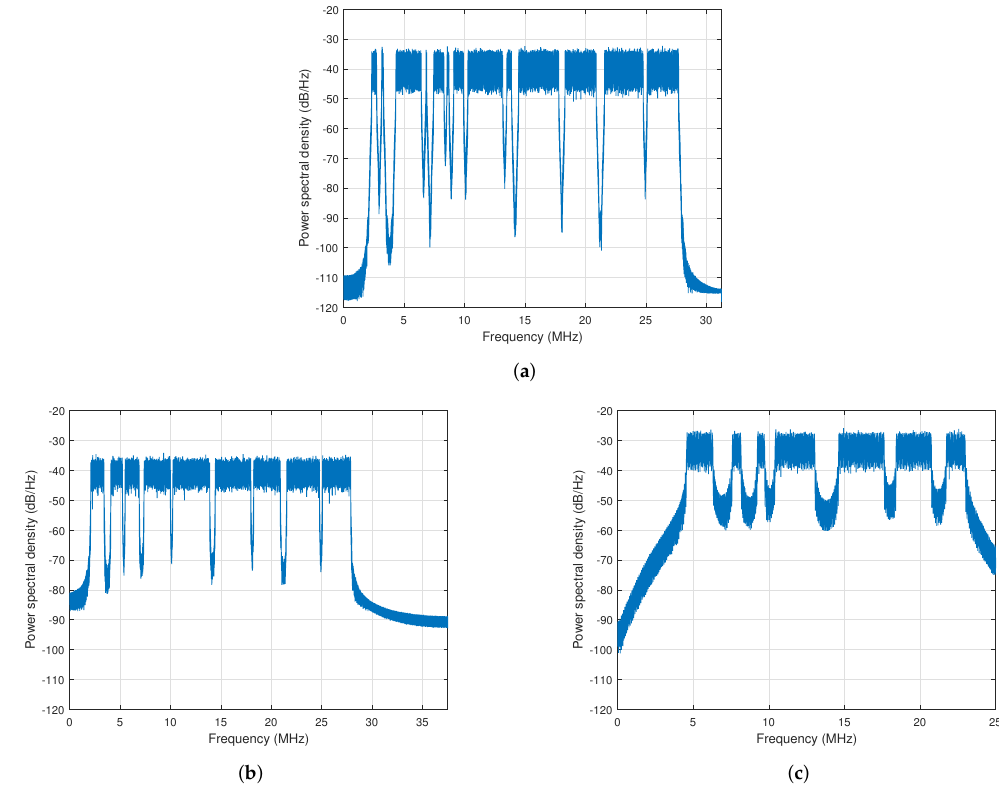
Figure 10. Power spectrum: ( a ) IoT PLC; ( b ) HPGP; and ( c ) HS